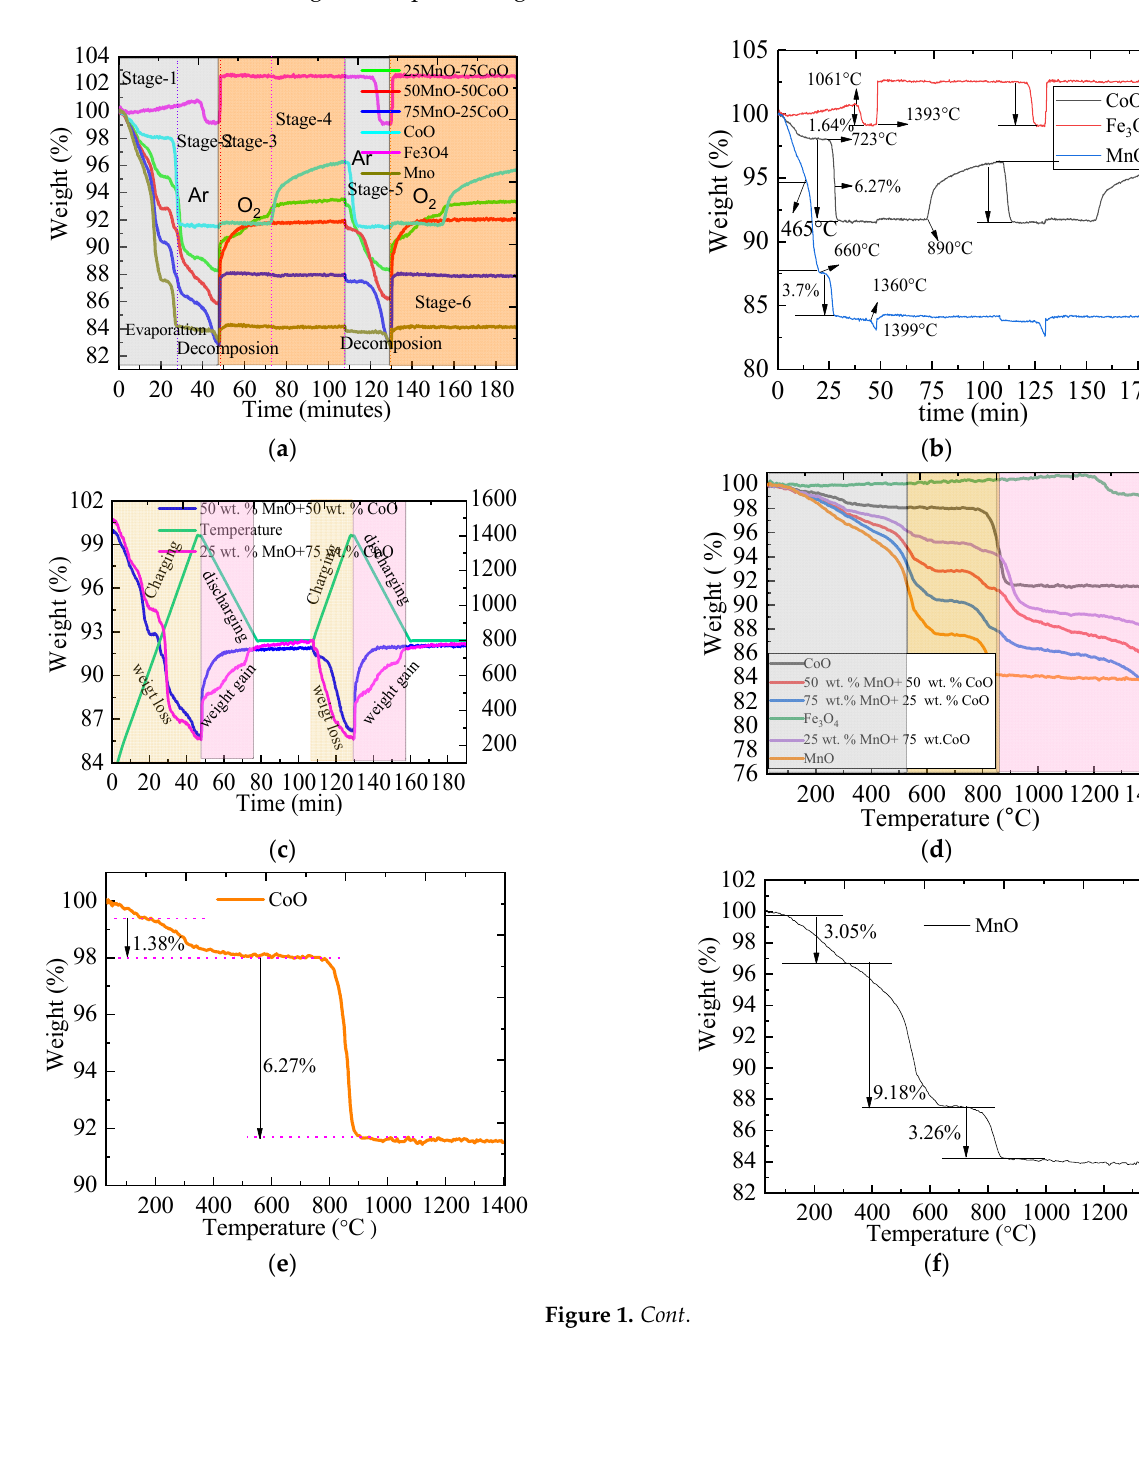
due to decomposition. Figure 1h depicted multi-stage decomposition. Figure 1i depicted the TGA with temperature and the percentage loss for 75 wt.% MnO + 25 wt.% CoO were 5.565 in the first stage and 3.775 in the second stage. Figure 1i showed the first stage of decomposition was higher than the second stage. This was due to the content of MnO being higher than CoO, and CoO is more vulnerable for decomposition than MnO. Figure 1j depicted the redox for 50 wt.% MnO + 50 wt.% CoO. As it has been seen from Figure 1j the percentage loss were 3.91 and 3.67 in the first- and second-stage decomposition, respectively. Figure 1k shows the TGA for 25 wt.% MnO + 75 wt.% CoO and 50 wt.% MnO + 50 wt.% CoO. From Figure 1k, it was noted that charging temperature (applied temperature) from 30 to 1400 ◦ C with 30 ◦ C/min heating rate led to a significant reduction of 30 mL/min Ar and/min O 2 , 25 wt.% MnO + 75 wt.% CoO, and all developed significant plateauing in reduction values of 50 wt.% MnO + 50 wt.% CoO around 1000 ◦ C.